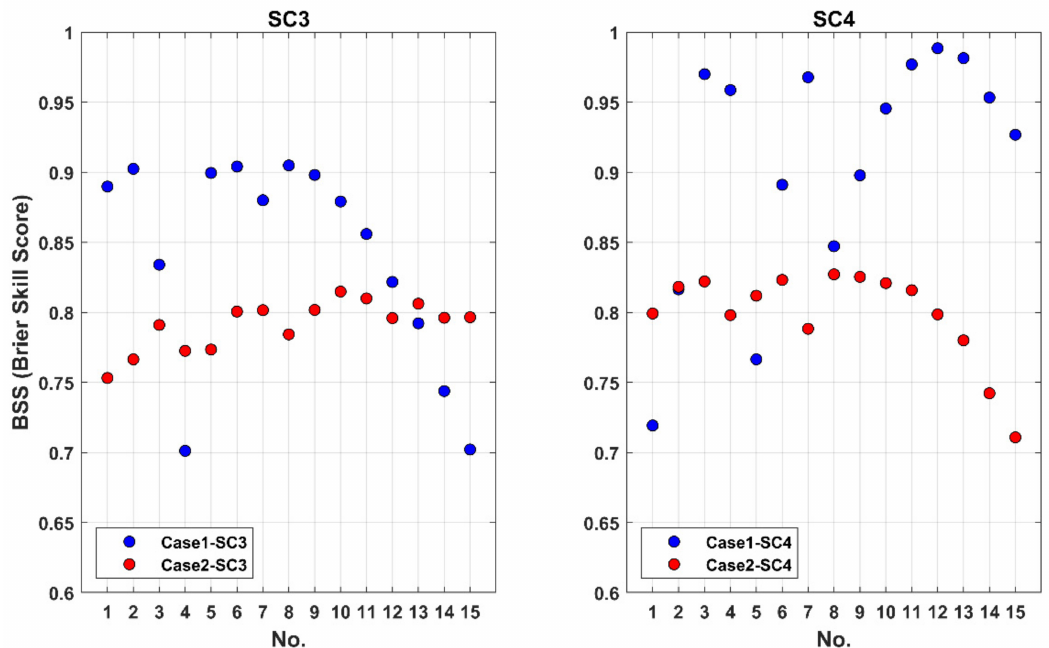
Figure 5. Brier-Skill-Score for computed final profile of SC3 and SC4: No. (simulation number in Table 3), Case1 (blue circle)—bed level above 0 m (MSL, Mean Sea level) and Case2 (red circle)—bed level between − 2 and 0